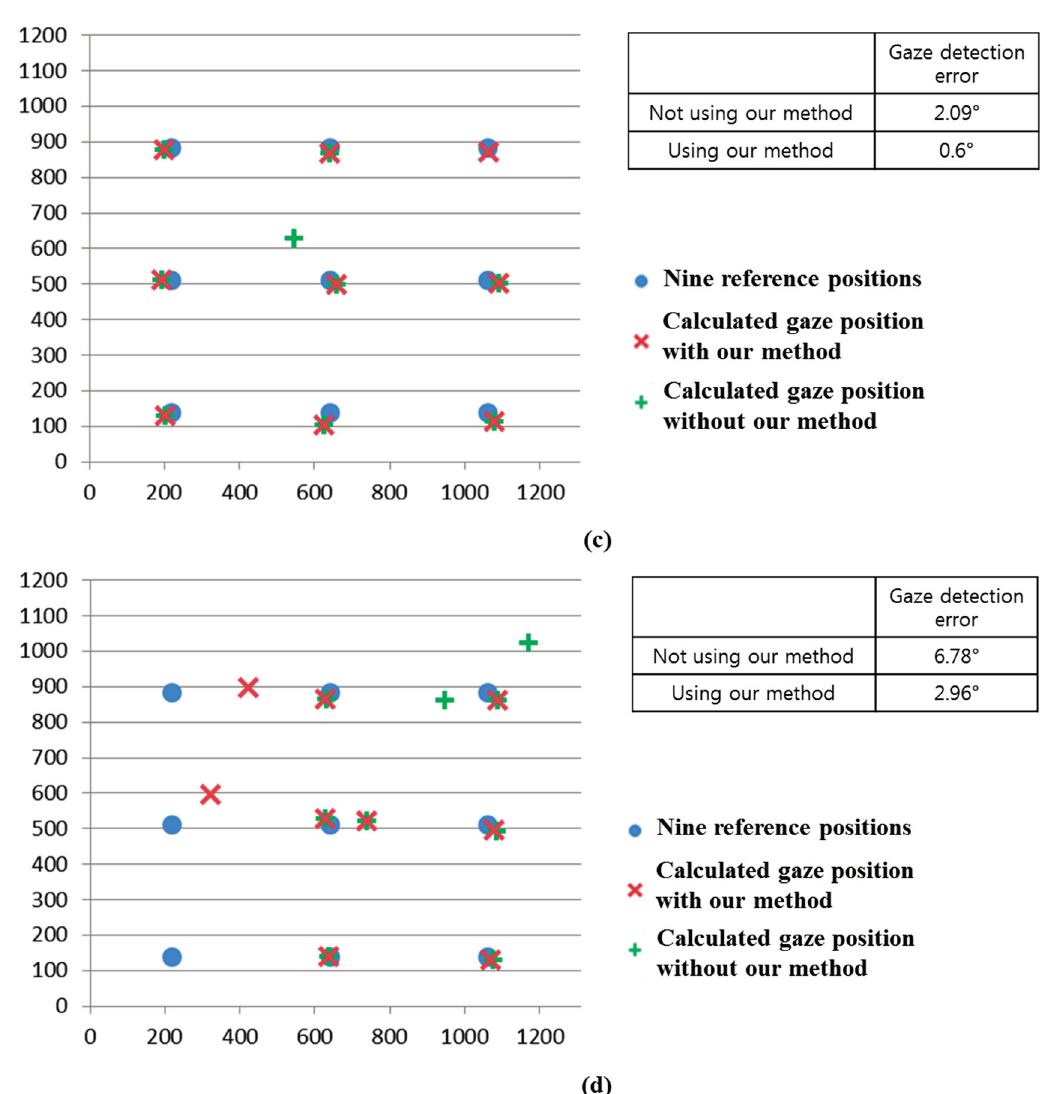
Figure 26. Comparisons of gaze detection errors without and with our method of Section 2.5 in case of the halogen lamp ( a ) above monitor display; ( b ) right of monitor display; ( c ) below monitor display; ( d ) left of monitor